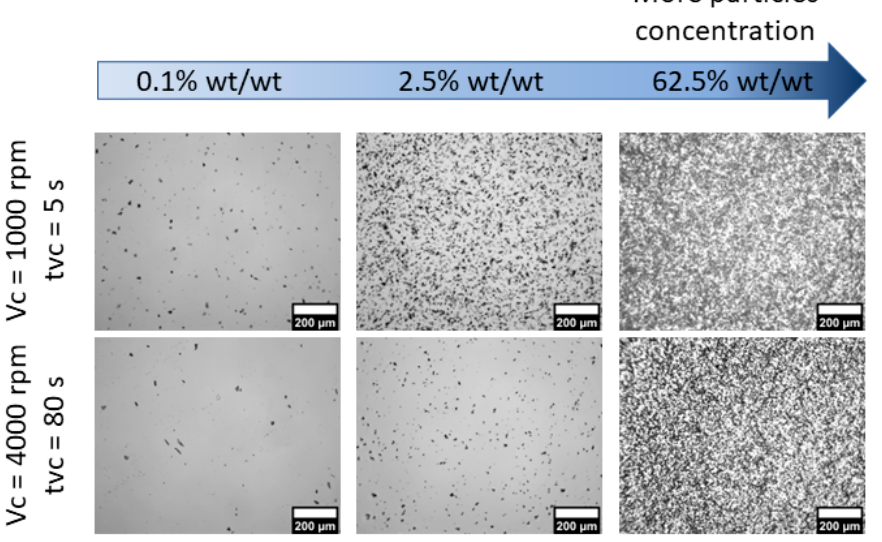
Figure 8. Optical microscopy images of membranes fabricated at 1000 rpm for 5 s ( upper row ) and at 4000 rpm for 80 s ( lower row ).